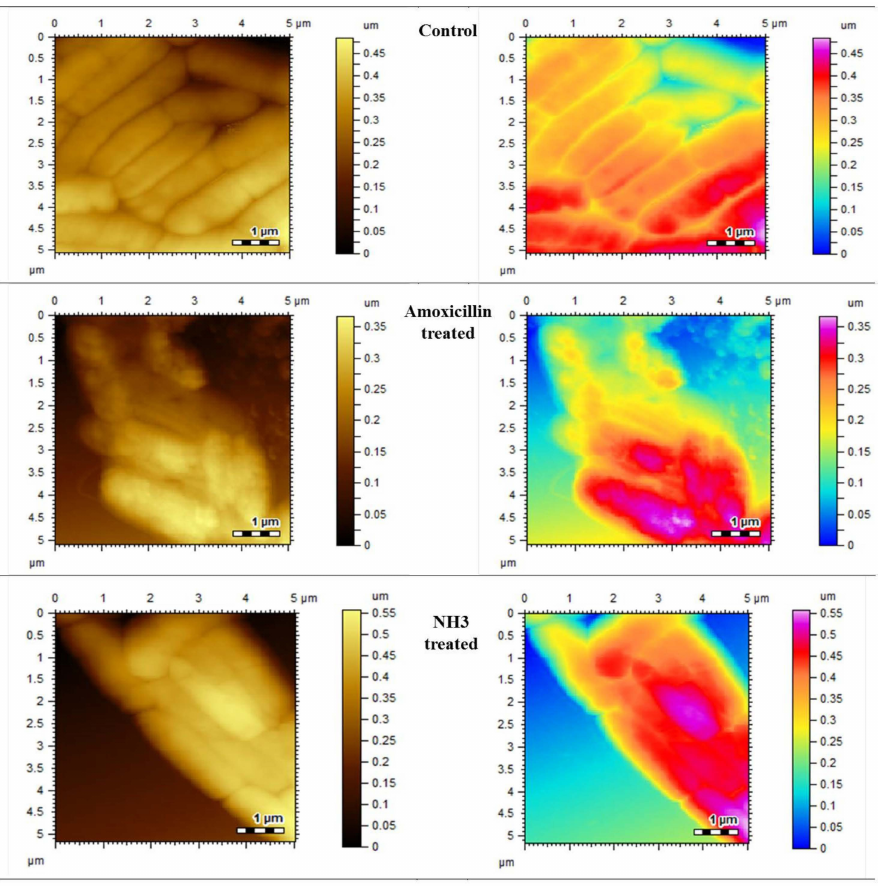
Figure 5. Atomic force microscopic images of control, standard and most effective treatment groups.